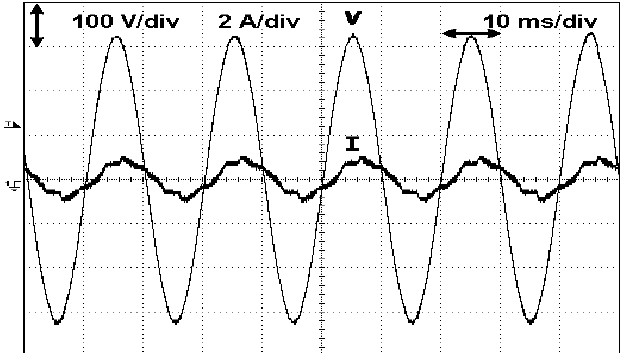
Figure 7. Voltage applied by the testing system and current injected by the solar inverter into the testing system when the injected power is 135 VA.